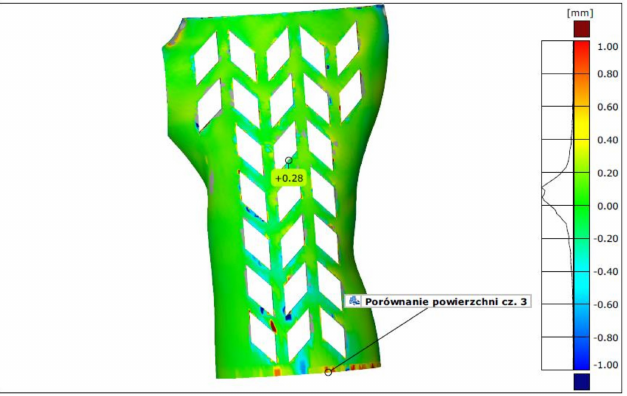
Figure 15. Exemplary result of accuracy examination, PLA, accura strategy and vertical